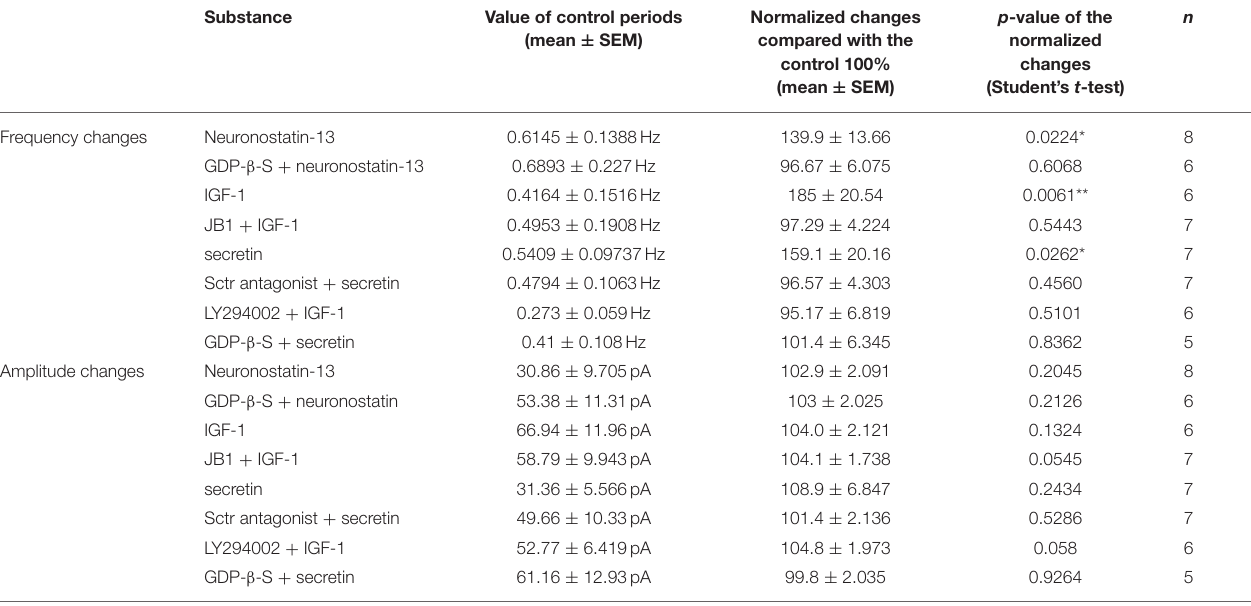
TABLE 4 | Changes in mPSC frequency and amplitude of GnRH neurons upon application of different substances. Substance Value of control periods Normalized changes (mean ± SEM) compared with